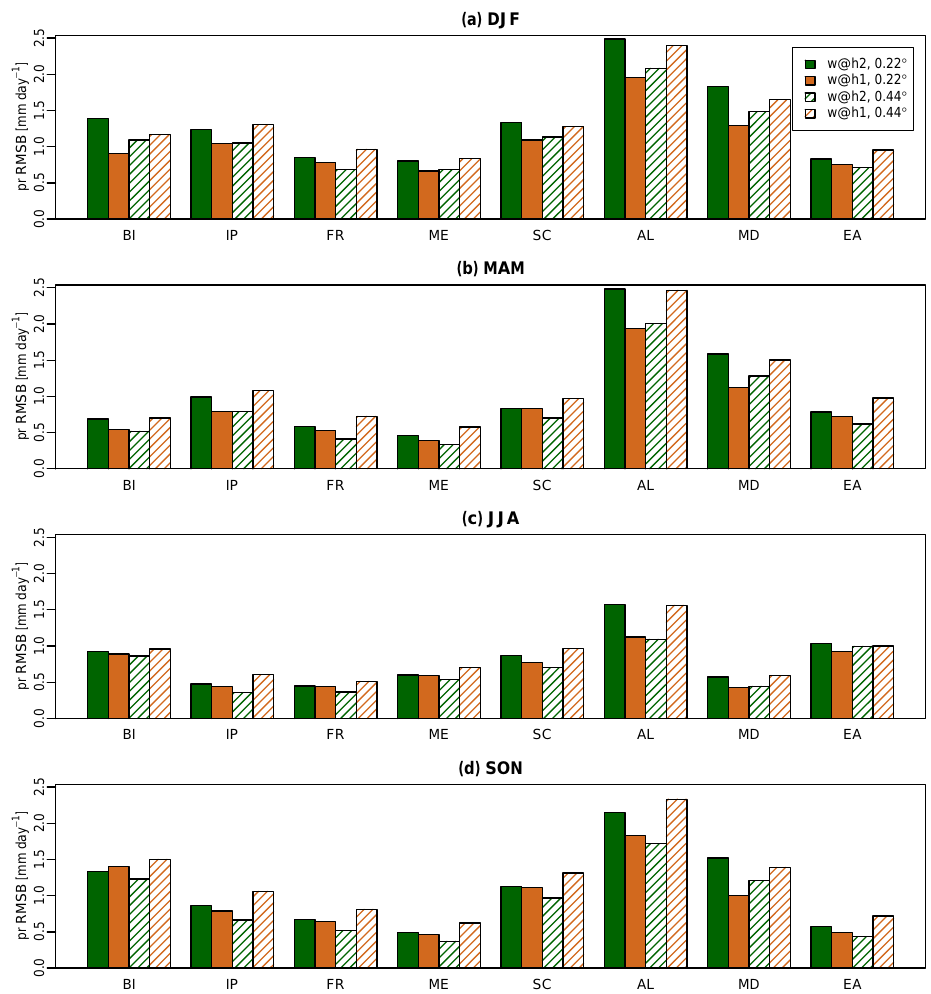
Figure 9. Same as Fig. 7 but for